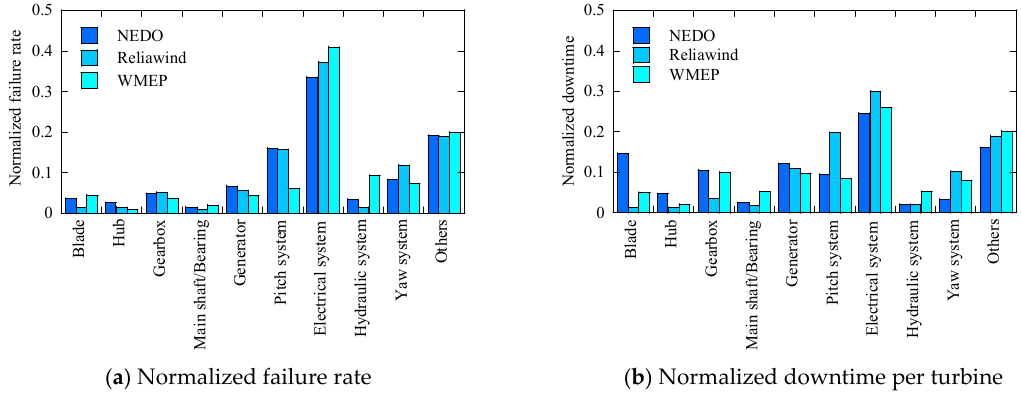
Figure 1. Comparison of ( a ) normalized failure rate and ( b ) normalized downtime between NEDO, Reliawind and WMEP databases.